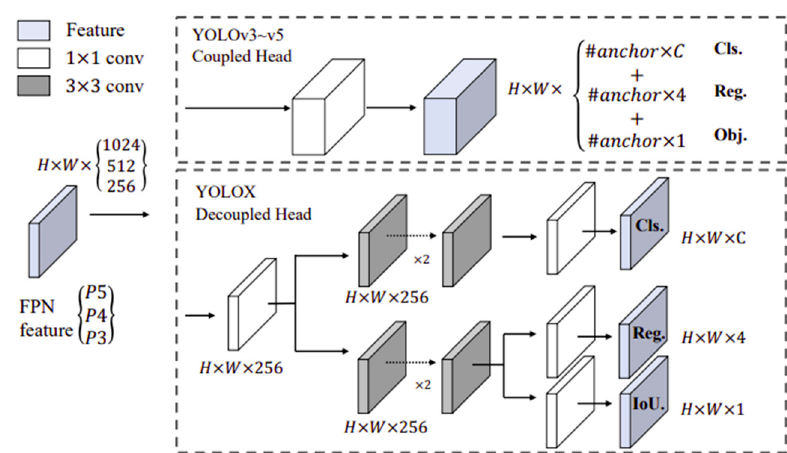
Figure 5. Comparison between YOLOX decoupling head and YOLO series.